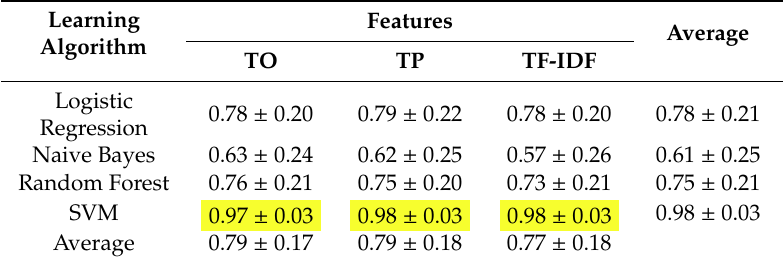
Table 5. Experimental results in which cells in yellow represent the best performing pair of learning algorithms and